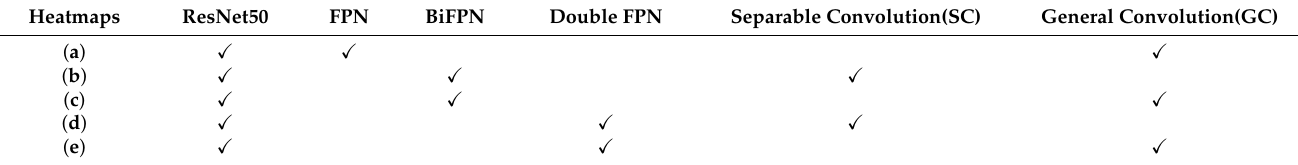
Table 1. Ablation study of feature maps. There are five different